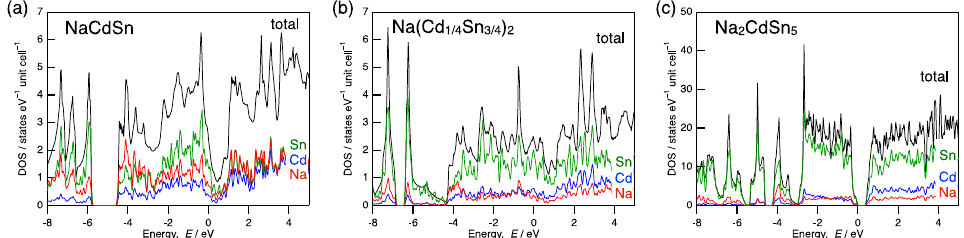
Figure 6. Total and partial DOSs calculated with ordered structure models for NaCdSn ( a ), Na(Cd 1/4 Sn 3/4 ) 2 ( b ), and Na 2 CdSn 5 ( c ).